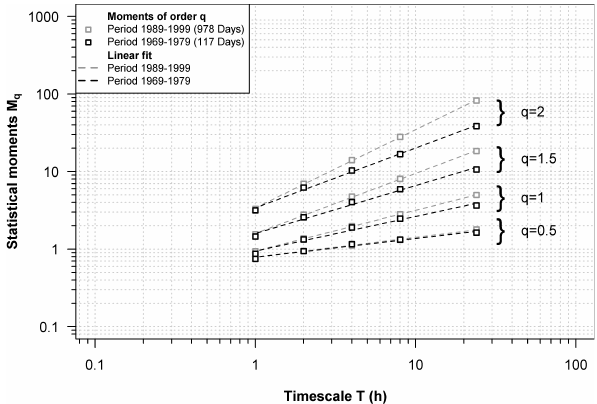
Fig. 2. Flowchart depicting the process of redistributing the rainfall volume of parent cells within a given cascade level between their child cells with branching number b = 2.